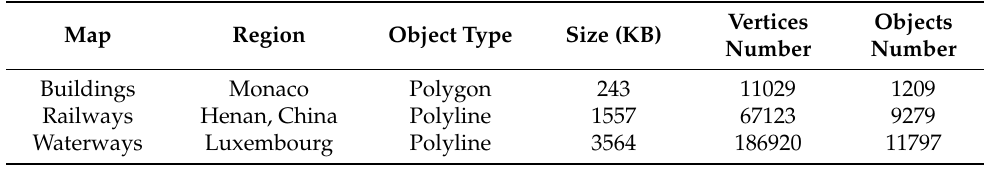
Figure 5. Original vector maps data: ( a ) buildings, ( b ) roads, ( c ) waterways. Figure 6. Watermark information: ( a ) original watermark, ( b ) shuffled watermark. Table 1. The detailed information of the GIS vector map data.